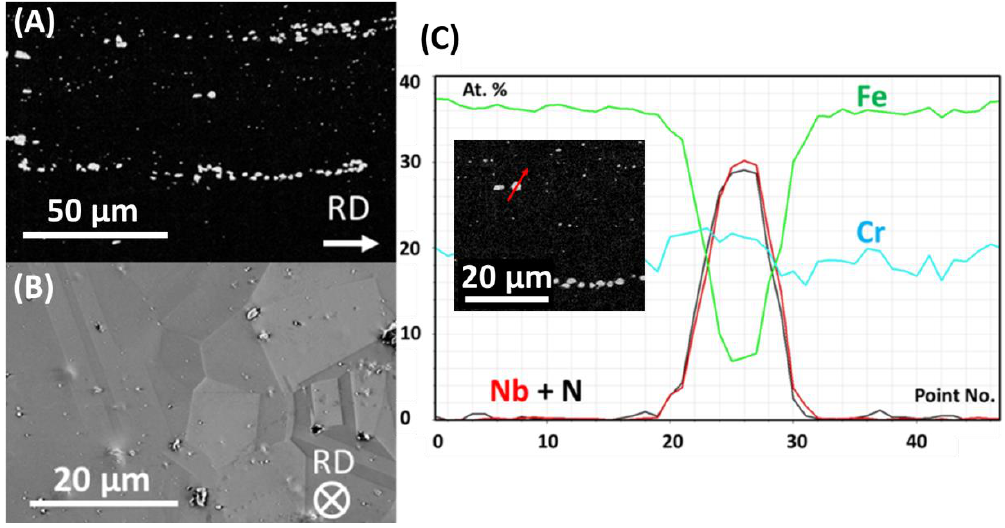
Figure 2. Microstructure of as-received Sanicro 25 steel: ( A ) longitudinal cross section, SEM-SE (contrast was enhanced to make primary precipitates very well visible), ( B ) transversal cross-section, SEM-SE, ( C ) results of SEM-EDS line scan along red arrow shown in the inset.